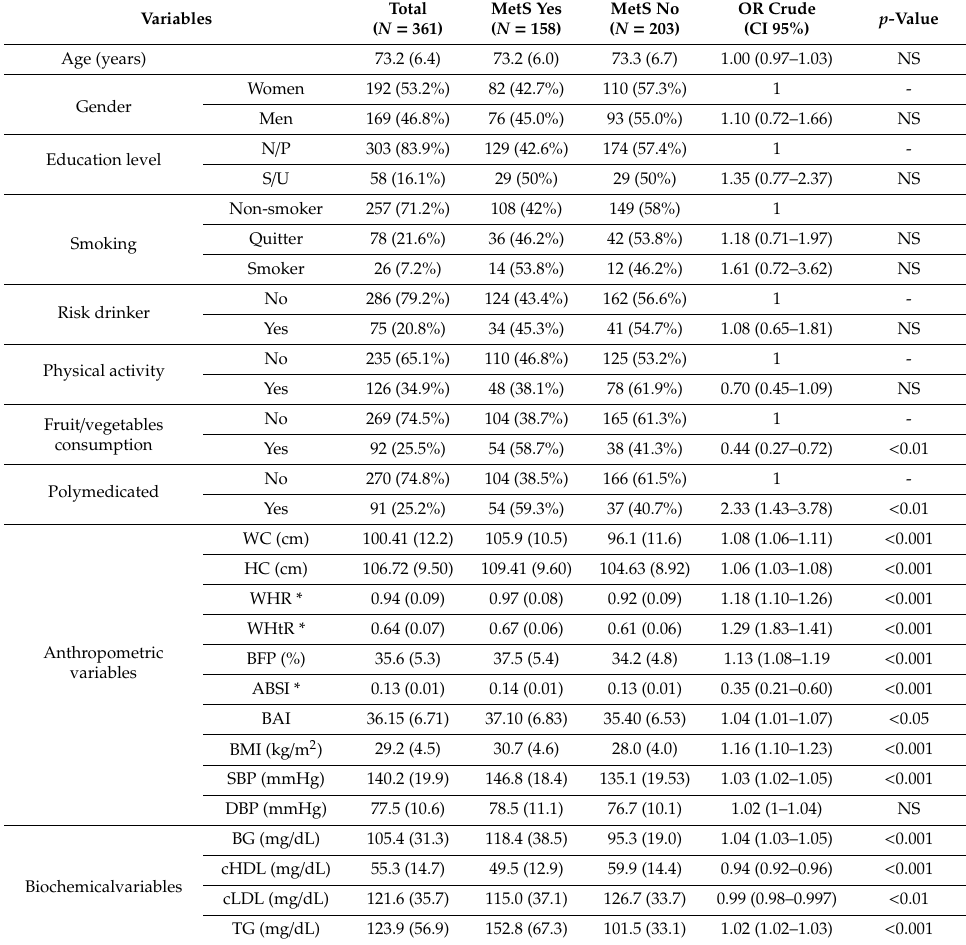
Table 1. Characteristics and logistic regression of the elderly population ( n = 361) with or without